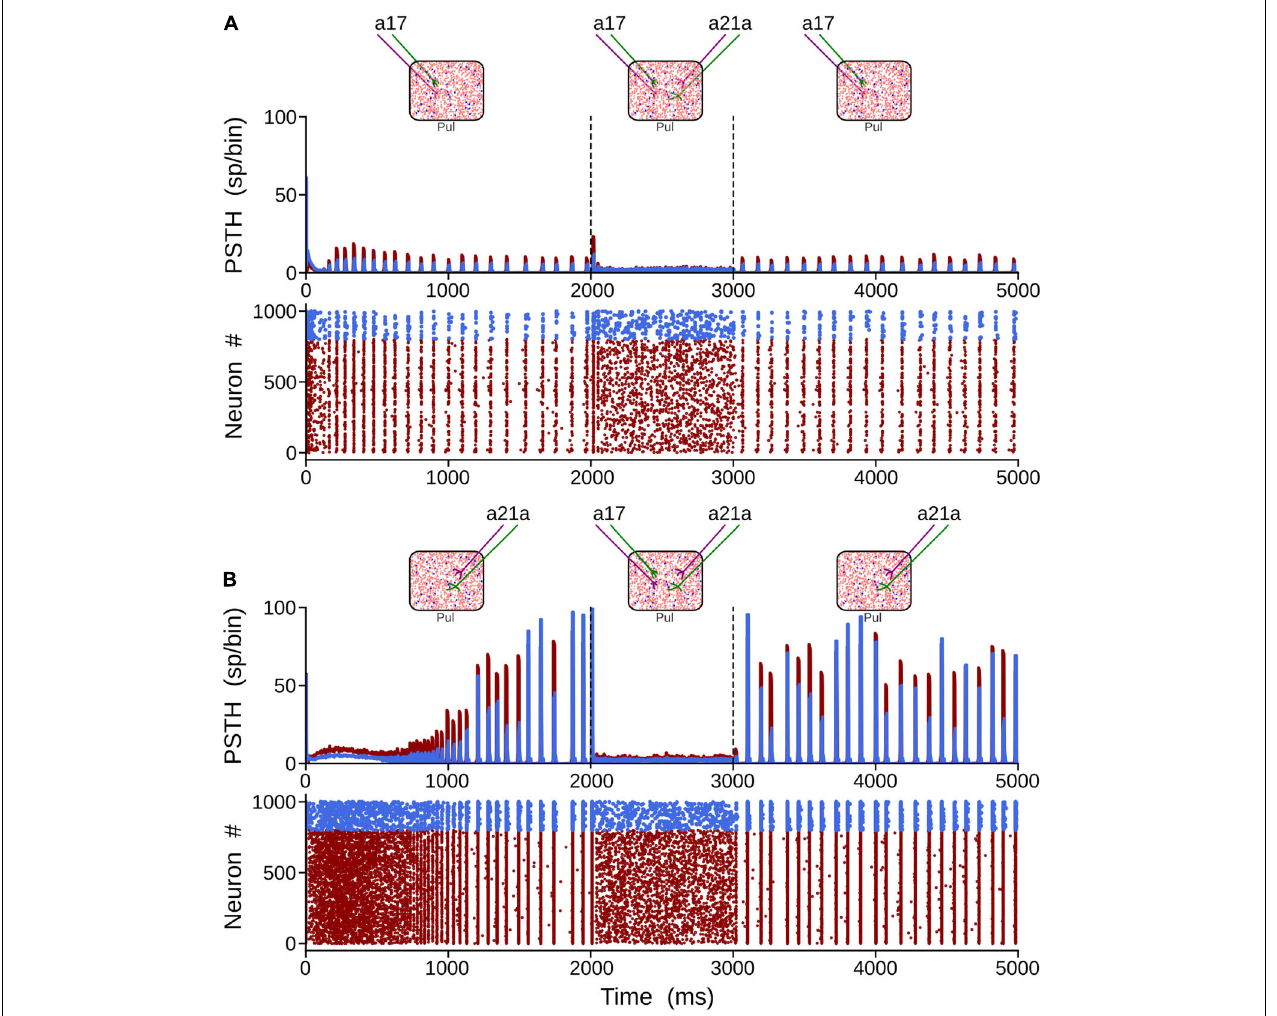
FIGURE 6 | Two solutions to generate alpha waves in the pulvinar. These solutions are found when η 1 = 0.5 and η 2 = 2.5 for area 17, and η 1 = 6.0 and η 2 = 1.0 for area 21a. Note that the thalamic alpha rhythms are ceased when the other area functionally targets the pulvinar (2–3 s). Solution for areas (A) 17 and (B) 21a. Terminal types 1 and 2 are represented by colors green and purple,